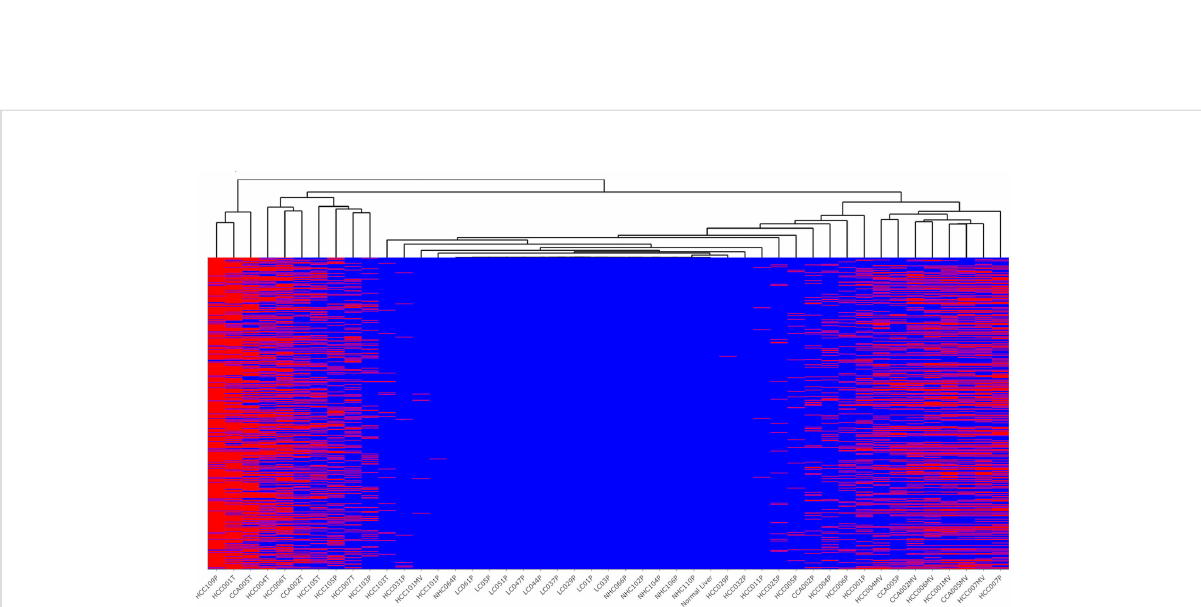
FIGURE 3 Pro fi le of top high-risk concordant variants detected selectively in the plasma and tumors of HCC patients. Indicated occurrence (red color) of 1,501 high-risk variants identi fi ed in plasma of HCC patients but not in liver cirrhosis and healthy controls, with clustering dendrogram of samples on the top. Most of the tumor samples were clustered on the left part of the fi gure, while the vesicle samples on the right side. The liver cirrhosis and healthy controls not carrying the variants (blue) stay in the middle section. The variant annotations and pro fi les of these variants is shown in Supplementary Table